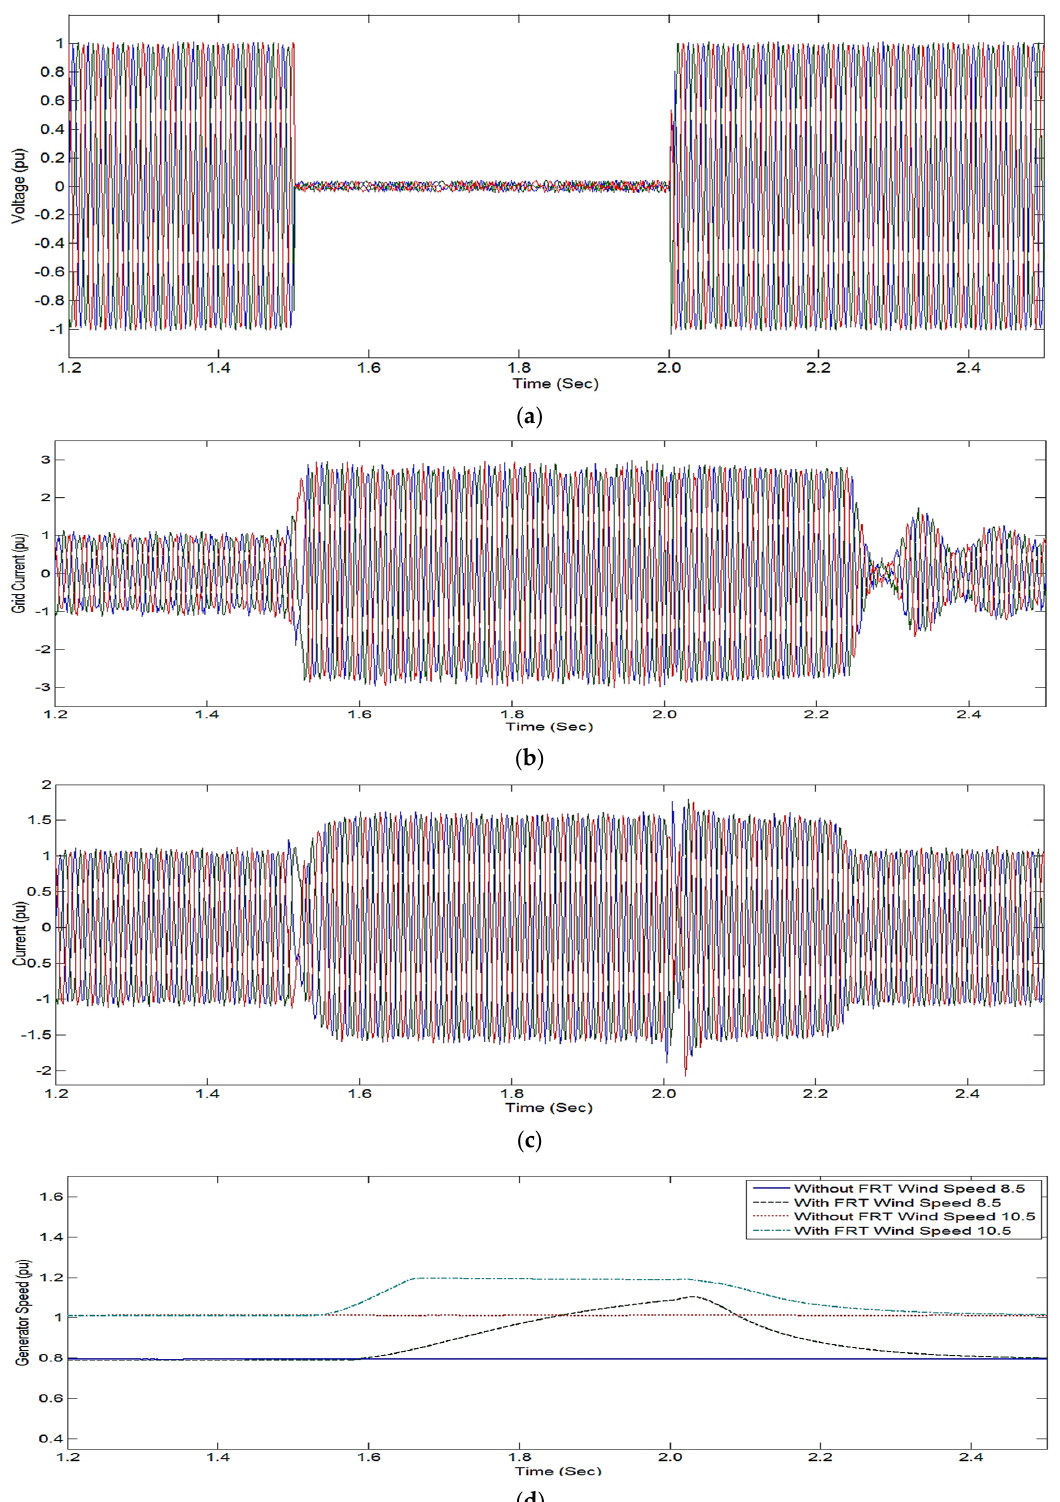
Figure 6. Behavior of WECS during symmetrical fault, with and without FRT control for 8.5 m/s and 10.5 m/s wind speeds: ( a ) Voltage at point of GGI; ( b ) Current through the point of GGI—without FRT control at 10.5 m/s; ( c ) Current through the point of GGI—with proposed strategy at 10.5 m/s; ( d ) Generator Speed.